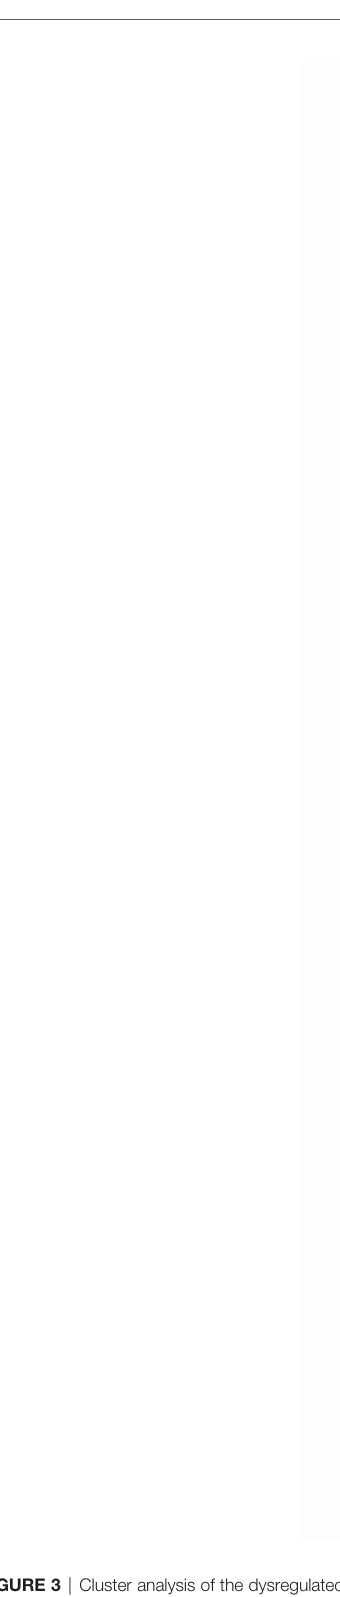
FIGURE 3 | Cluster analysis of the dysregulated miRNA components from HS EVs. The list of all 202 signi fi cantly differentially expressed miRNAs (HS-EV group/ control EV group) has been shown in heat